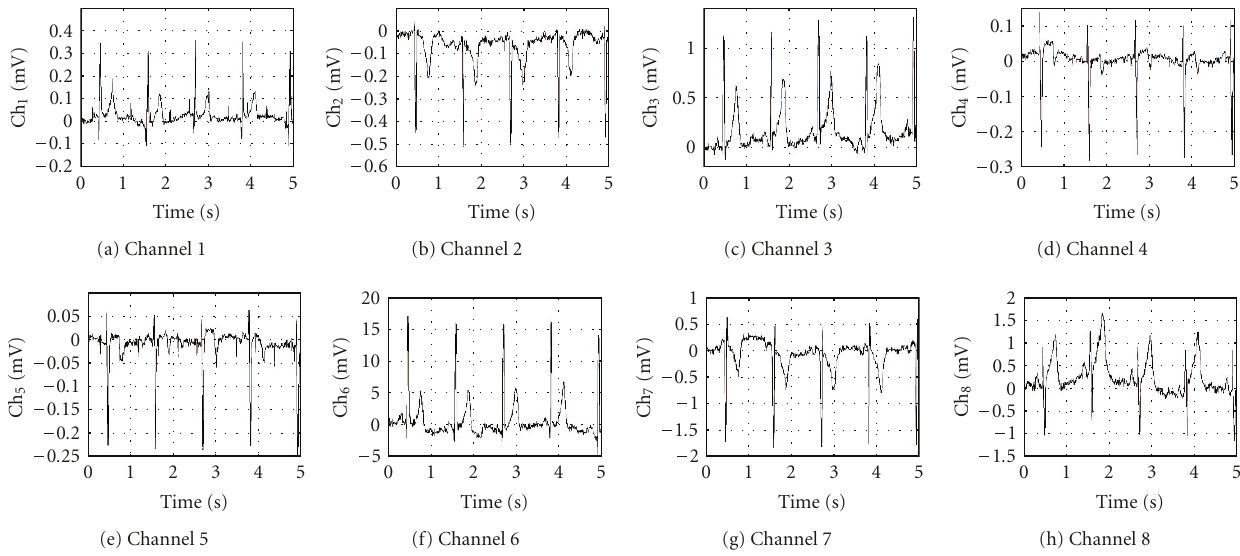
Figure 9: Synthetic multichannel signals from the maternal abdomen (channels 1–5) and thorax (channels 6–8). Notice the small fetal components with a frequency almost twice the maternal heart rate in the abdominal channels.